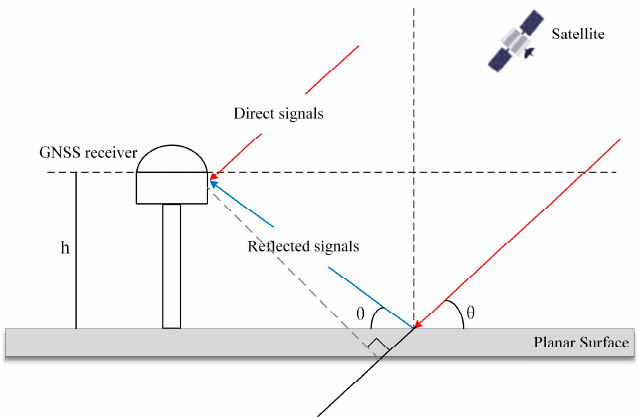
Figure 1. Schematic diagram of GNSS reflected signals.